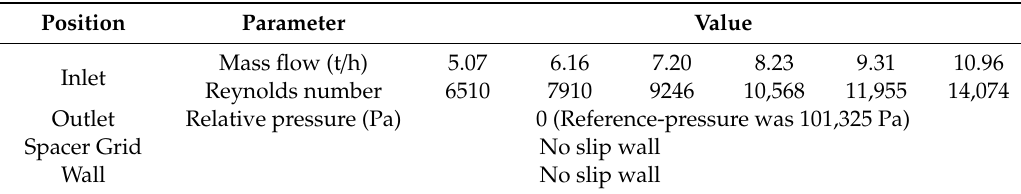
Table 2. Boundary conditions.